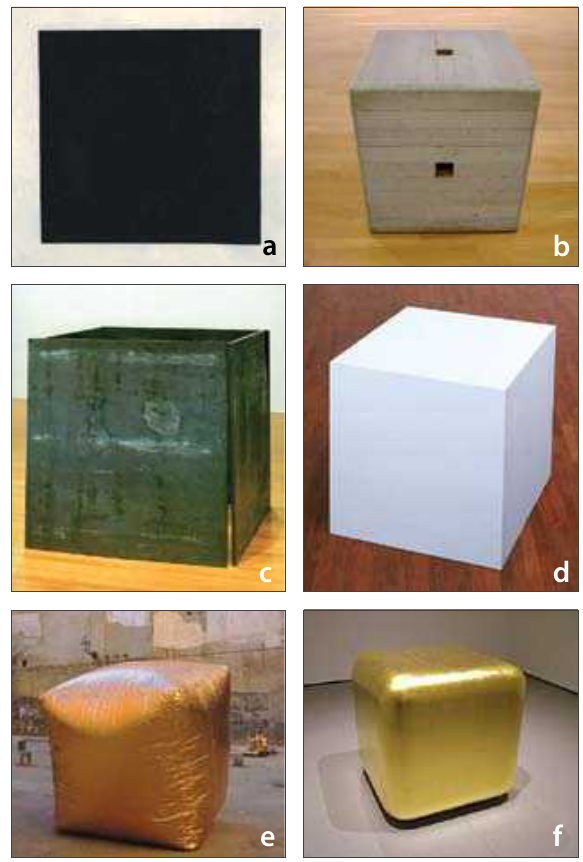
Fig. 3. black Square. kazimir Malevich, 1913–1915 (a); Green Piece. Jackie Winsor, 1976–1977 (b); One ton Prop (house of cards). richard Serra, 1969 (c); Untitled. tom Friedman, 1995 (d); basic house. Mobile installation. ruiz de azua, 2000 (e); the table of Perfect (gold leaf on white marble). James Lee byars, 1989 (f)